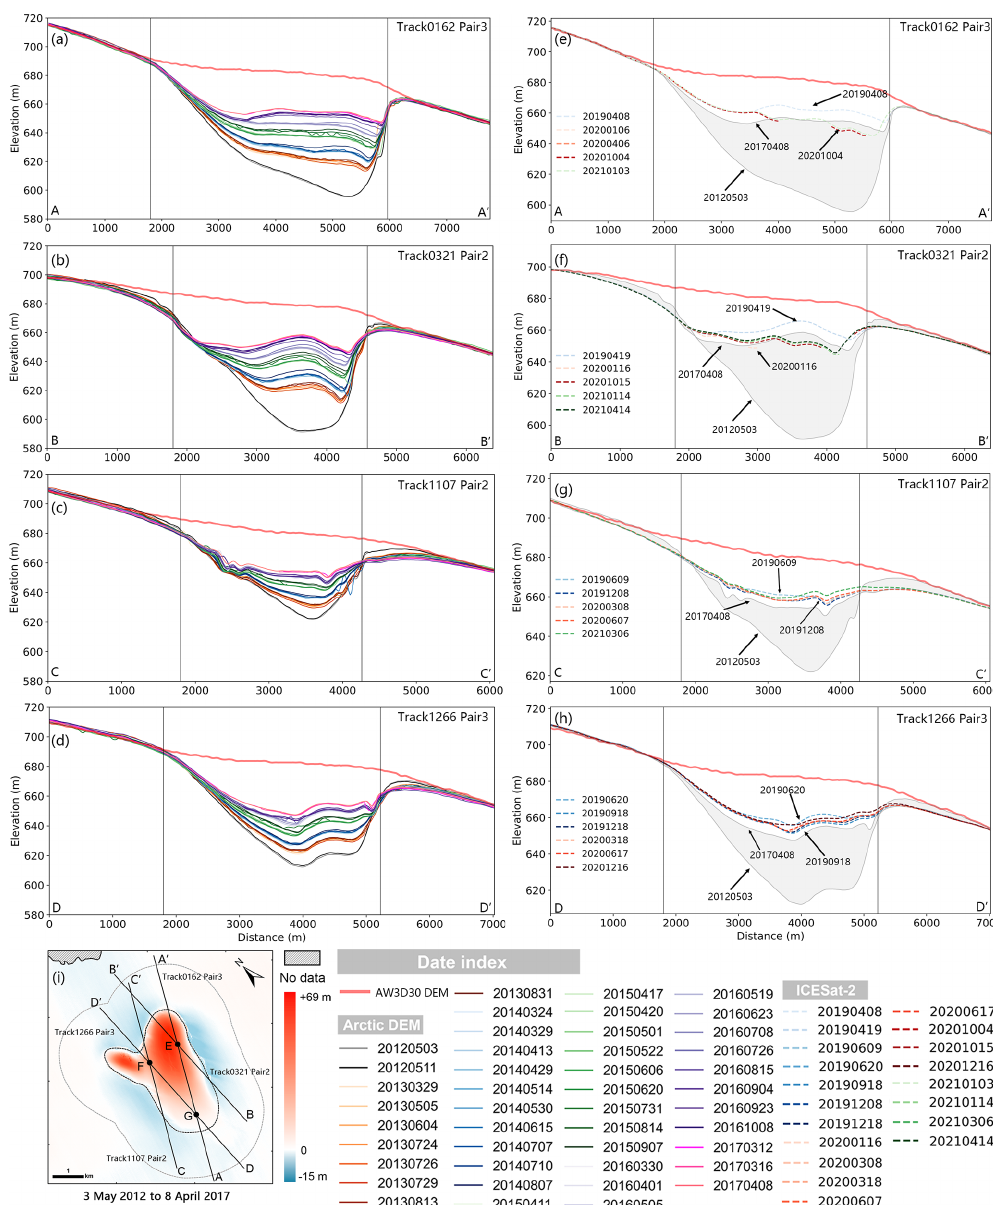
Figure 2. Surface elevation changes from 2012 to 2021. (a–d) Repeat elevation profiles derived from ArcticDEM data from 2012 to 2017. The starts and ends of the profiles AA (cid:48) , BB (cid:48) , CC (cid:48) and DD (cid:48) are shown in (i) . The thick solid red line represents the elevation profile derived from the AW3D30 DEM, which has a timestamp of 2006–2010. The vertical lines demonstrate the position of the collapse basin boundary. (e– h) Same as (a) – (d) but derived from ICESat-2 data acquired between 2019 and 2021. The light gray area indicates the range of steady surface uplift between 2012 and 2017. (i) Change in surface elevation between 5 May 2012 and 8 April 2017 (DEM20170408 − DEM20120505). The solid lines show the position of the reference track used to extract the elevation profiles. The dashed black curve is the boundary of the collapse basin, which has an area of about 7.6km 2 . The dashed gray curve demonstrates the 1500m buffer area that was used to calculate the ice inflow volume. The map projection is polar stereographic (EPSG:3413). Dates are in the format